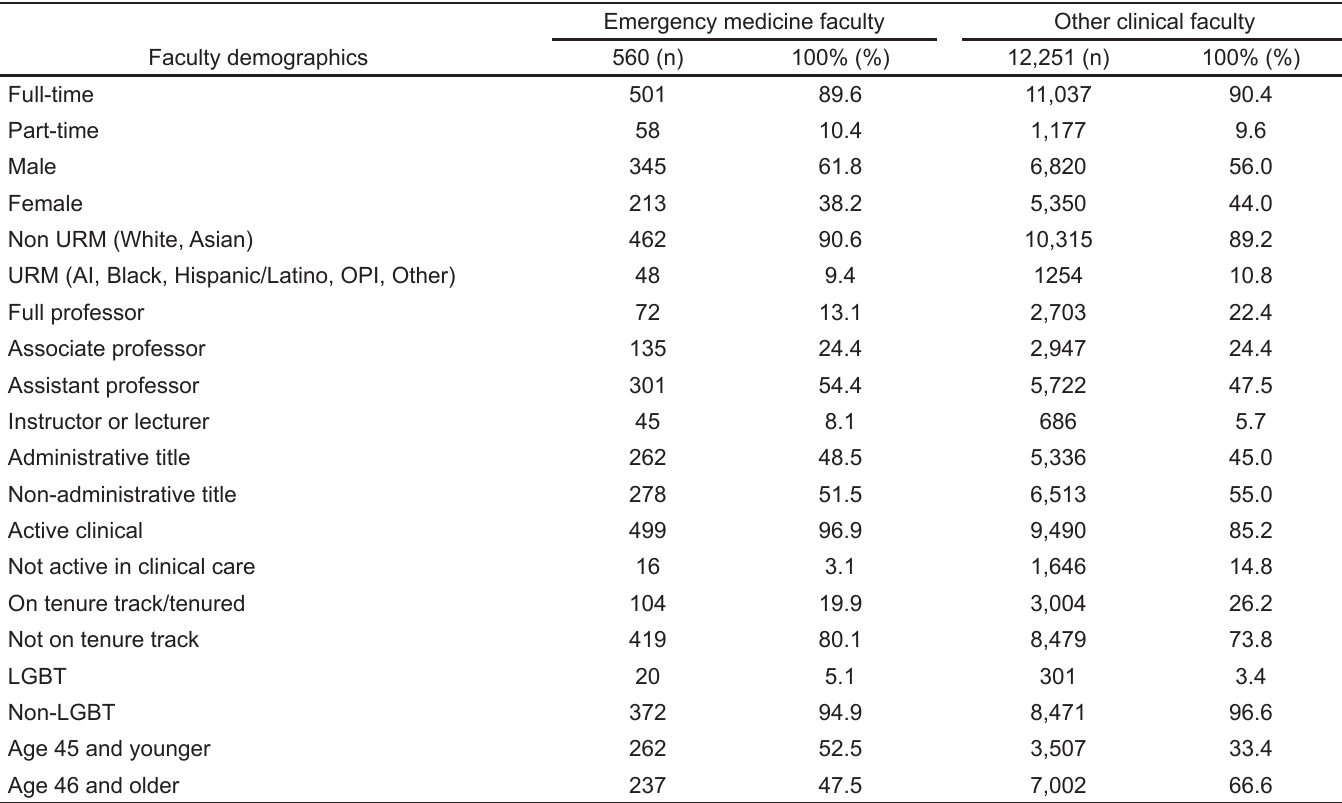
Table 1. StandPoint Survey clinical faculty respondents by demographic categories.